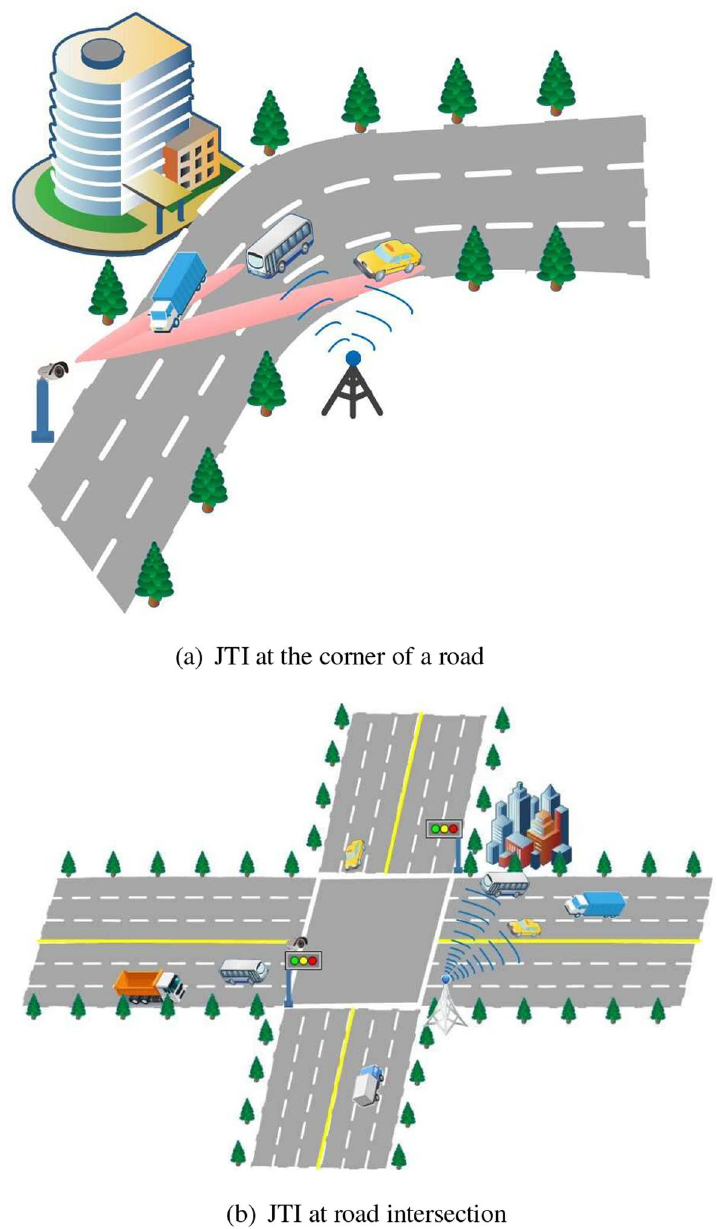
Fig. 1 JTI problems in complex traffic